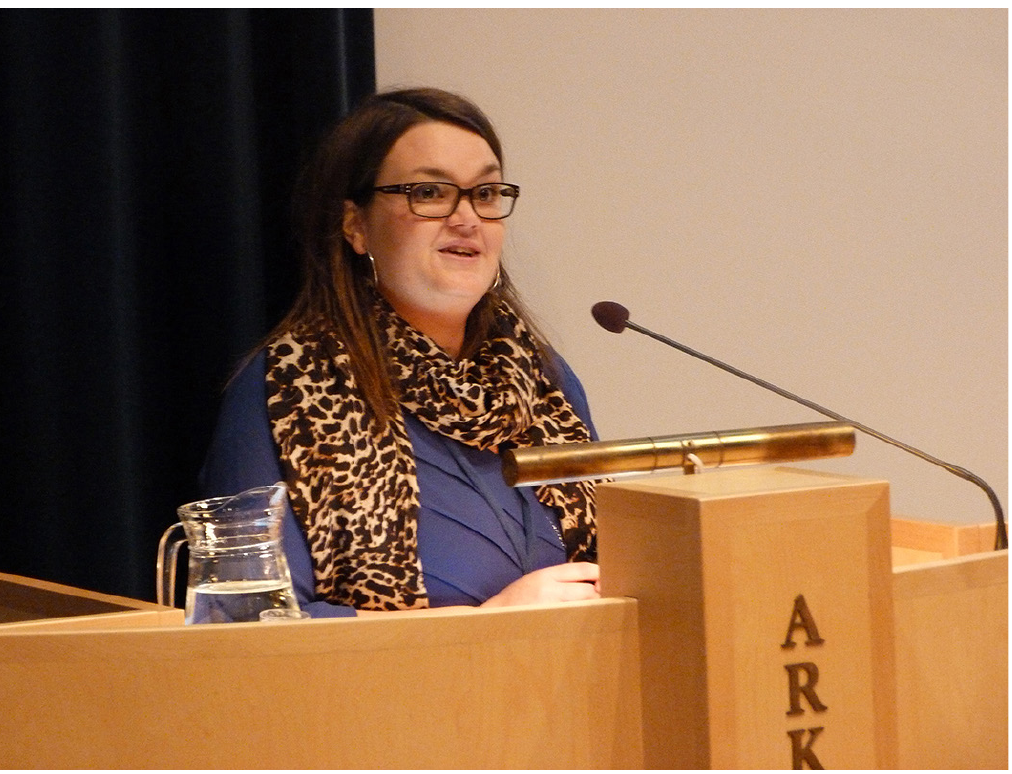
Figure 2. Keynote speaker, Dr. Annette Löf from Umeå University discussed the challenges of sustainable reindeer husbandry (Photo: Berit